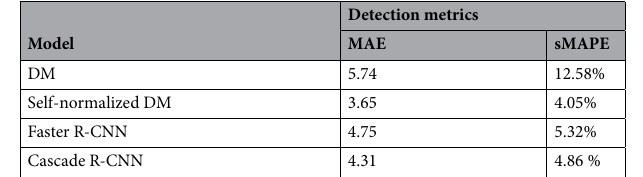
Table 2. Counting metrics, mean absolute error (MAE) (Eq. 10) and symmetric Mean Absolute Percentage Error (sMAPE) (Eq. 11), for the DM and SNDM model (in MC dropout) in comparison with other counting methods that use popular R-CNN object detectors: Faster 37 and Cascade 38 , which are discussed by Majchrowska et al. 23